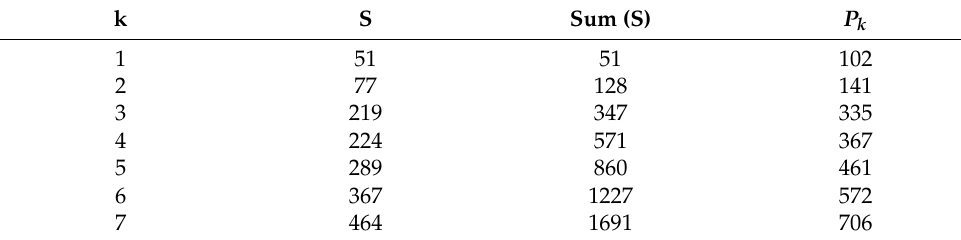
Table 2. Proposed Fast Estimation on S